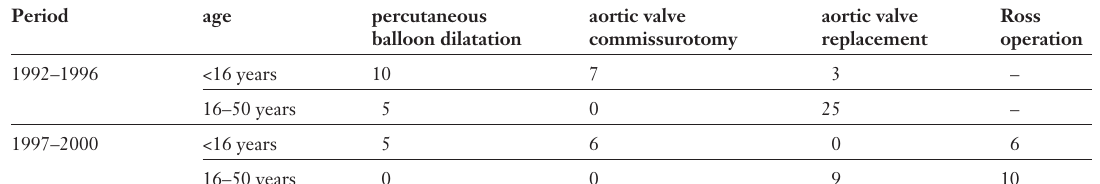
A. Intraoperative photograph of the diseased native aor- tic valve in a child who underwent the Ross procedure at 9 years of age, after previous pulmonary balloon dilatation at 5 months of age. B. Intraoperative photograph of the same child during implantation of the pulmonary autograft (Ross operation) with the root replacement technique, with reim- plantation of the coronary